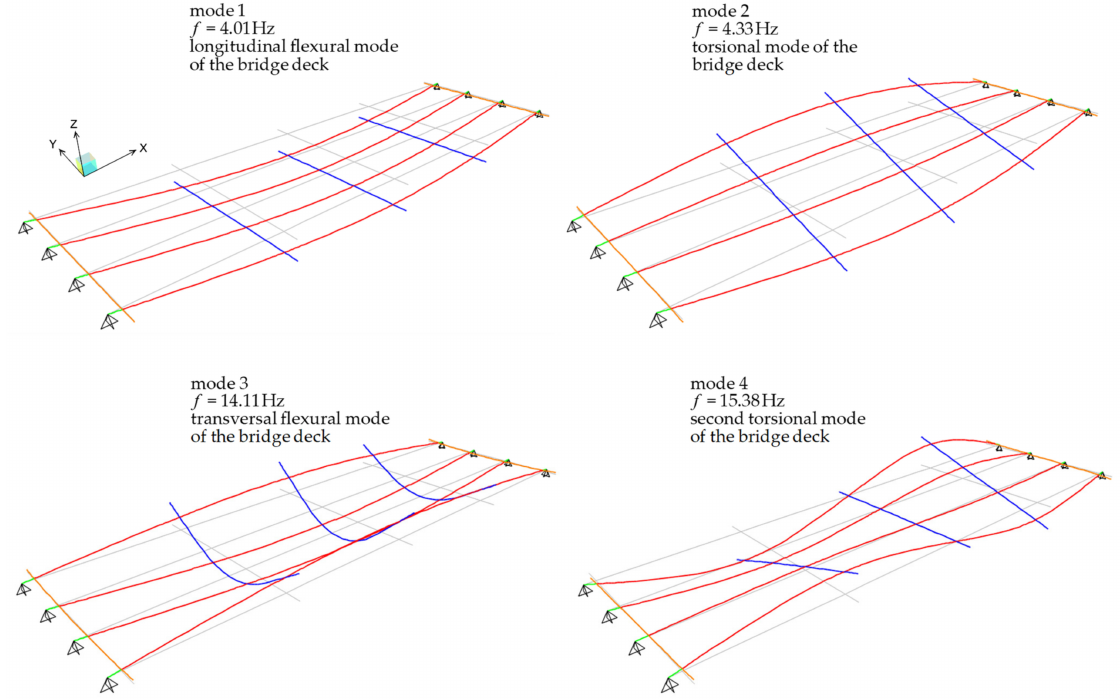
Figure 12. First four mode shapes obtained from FE model of the bridge